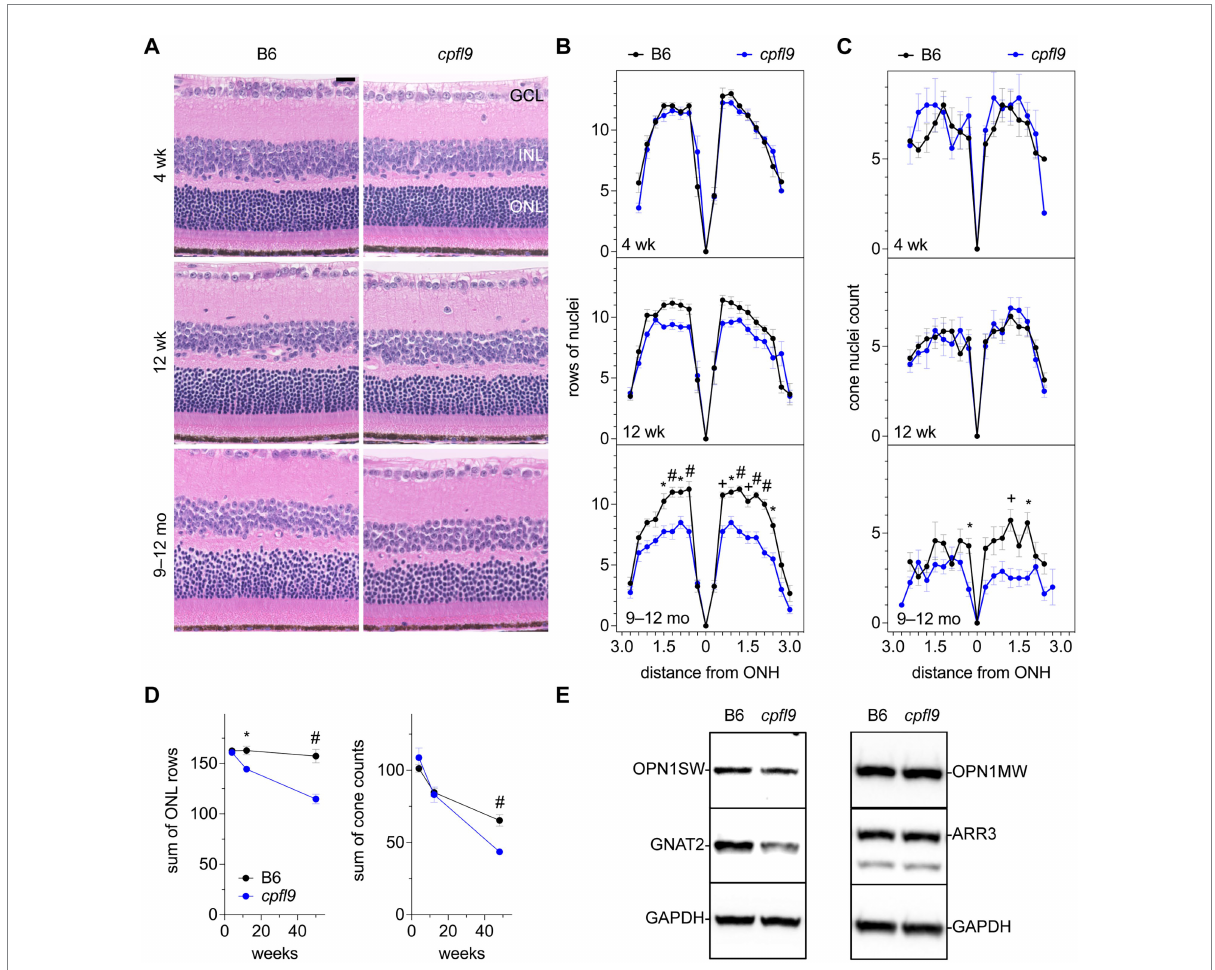
FIGURE 3 Effect of cpfl9 mutation on retinal morphology and OS protein expression. (A) Retinal sections of cpfl9 and B6 control eyes show similar hematoxylin-stained outer nuclear layer (ONL) thickness at 4 and 12 weeks of age. In contrast, at 9–12 months of age cpfl9 mutants showed a thinned ONL compared to controls. GCL, ganglion cell layer; ONL, outer nuclear layer; INL, inner nuclear layer. Scale bar: 20 μ m. Images are representative of slide scans from n = 4–8 cpfl9 and n = 4–12 B6 mice at all ages. (B) Longitudinal quantitation of the number rows of ONL nuclei within a 50- μ m length of retina as a function of distance from the optic nerve head (ONH). B6 control mice, black circles; cpfl9 mice, blue circles. Values represent mean ± standard error of the mean (SEM); n = 4–6. Statistically significant differences from post hoc multiple comparison testing of row counts between the strains are indicated by symbols: *, p < 0.05; +, p < 0.001; #, p < 0.0001. (C) Longitudinal quantitation of cone photoreceptor nuclei within a 100- μ m length of retina at regular intervals from the ONH. Values represent mean ± SEM; n = 4–12. Statistically significant differences from post hoc multiple comparison testing of cone counts between the strains are indicated by *, p < 0.05; +, p < 0.001. (D) Progressive change with age in the number of rows of ONL nuclei and cone nuclei counts summed over all retinal regions as measured in panels B and C . Values represent mean ± SEM; n = 4–12. *, p < 0.05; +, p < 0.001; #, p < 0.0001. (E) Western analysis of retinal lysates probed with antibodies against cone-specific OS proteins: S opsin (OPN1SW), M opsin (OPN1MW), cone arrestin (ARR3) and G protein subunit alpha transducin-2 (GNAT2). GAPDH was used as a loading control. Western analysis indicated decreased expression of GNAT2 in cpfl9 compared to B6 retinas at 12 weeks of age. Images are representative of lysates from n = 4 cpfl9 and n = 5 B6 mice analyzed in separate lanes of the same